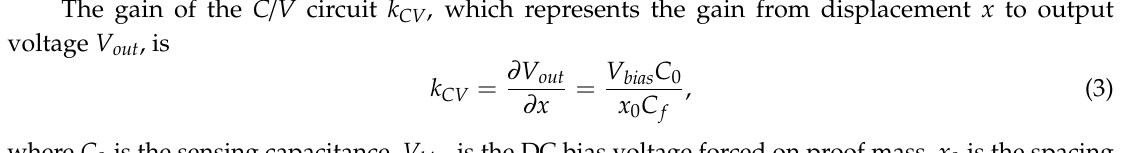
Figure 4. C / V circuit implemented by a charge amplifier.